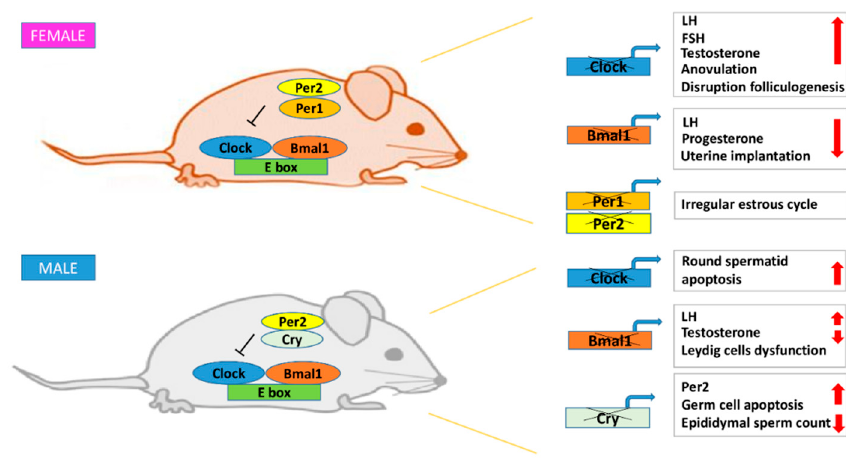
Figure 3. Schematic representation of infertility complications due to clock gene disruption on female and male knockout